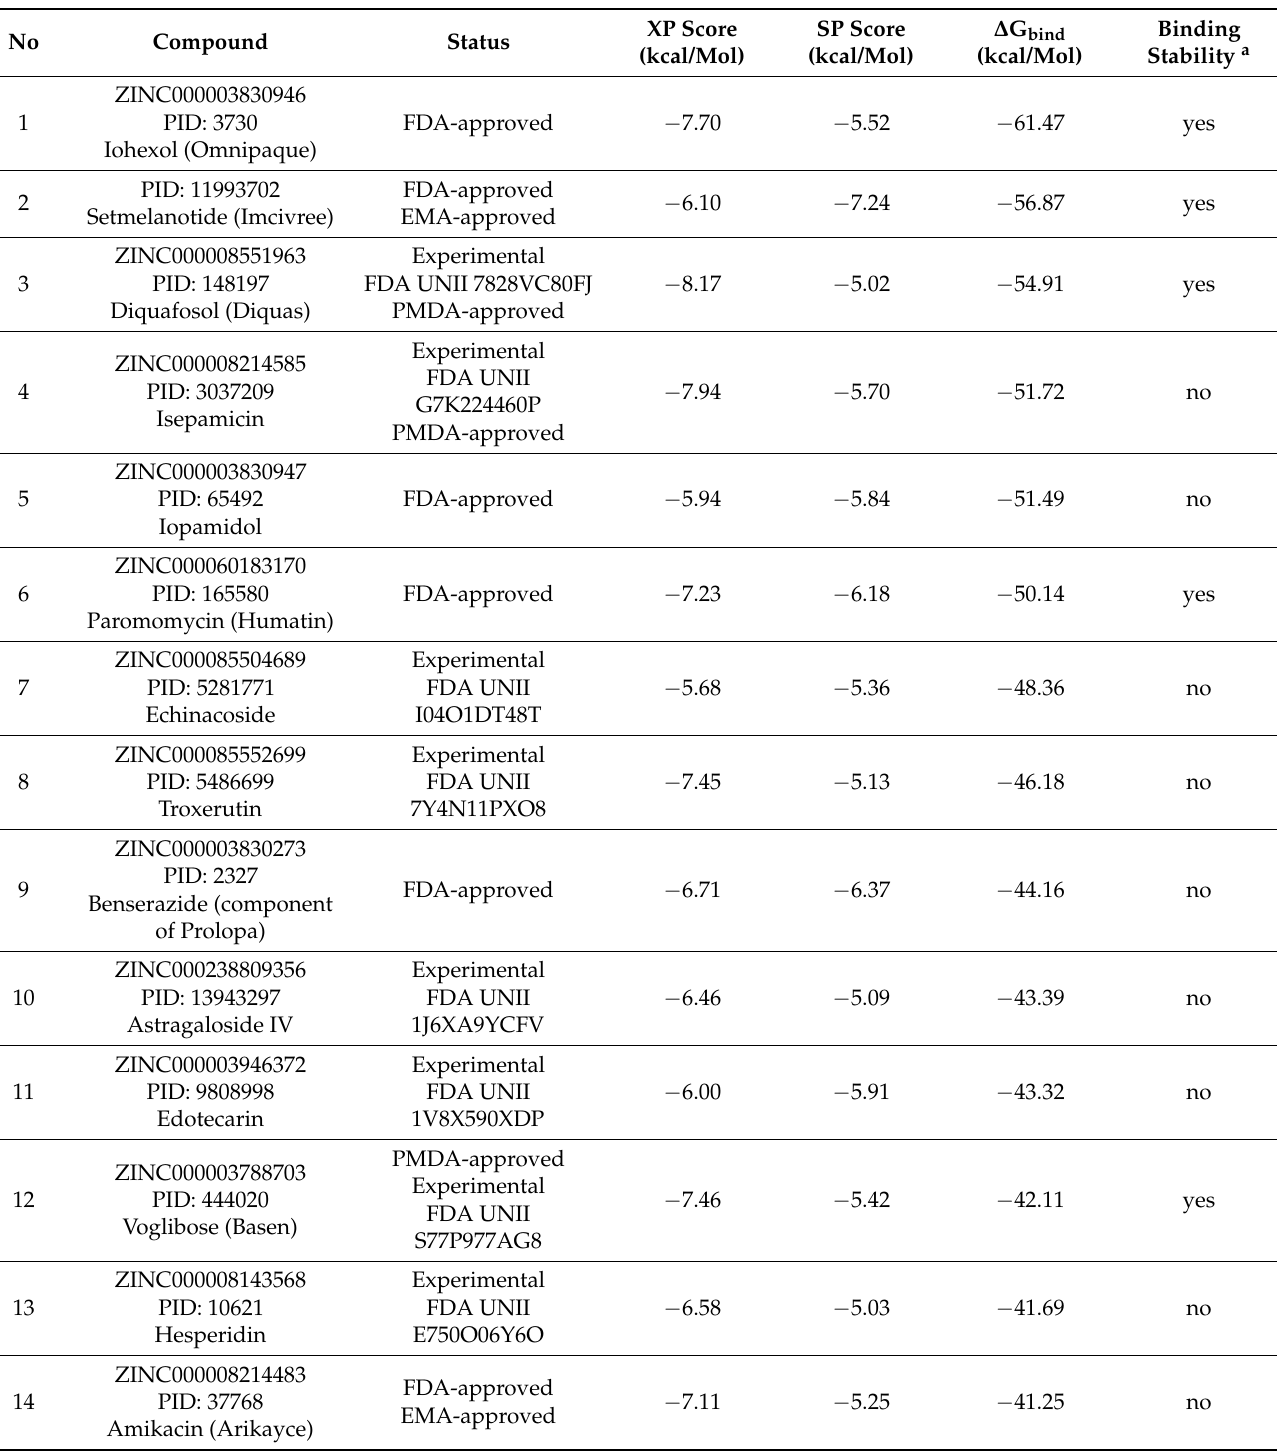
Table 2. Output of the high-throughput docking campaign, with the ranking of approved drugs based on the applied computational